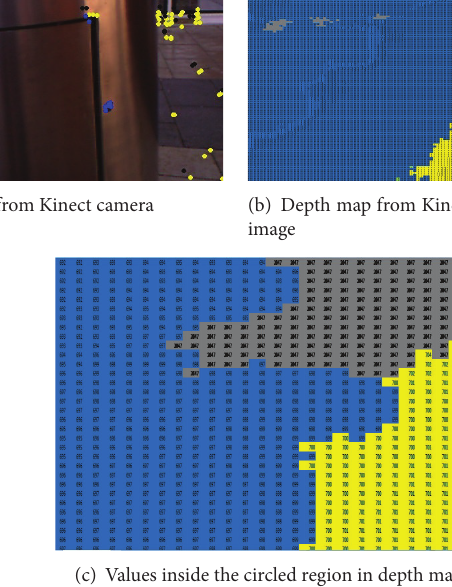
Figure 5: Kinect output: an RGB image and its corresponding depth map; colours in the depth estimated map represent distance from the sensor based on distance threshold: green color shows possible hazard, whereas blue color represents potential hazard and black points are the areas from which the sensor is unable to get sensible depth and the values are 2047.